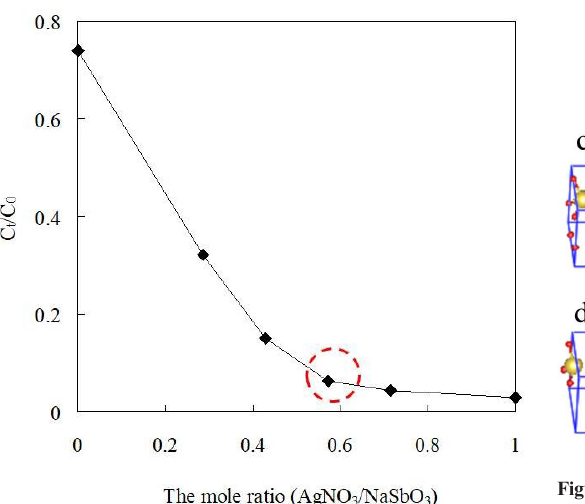
Figure 2. The effect of mole ratio (AgNO process on the removal rate of MB.